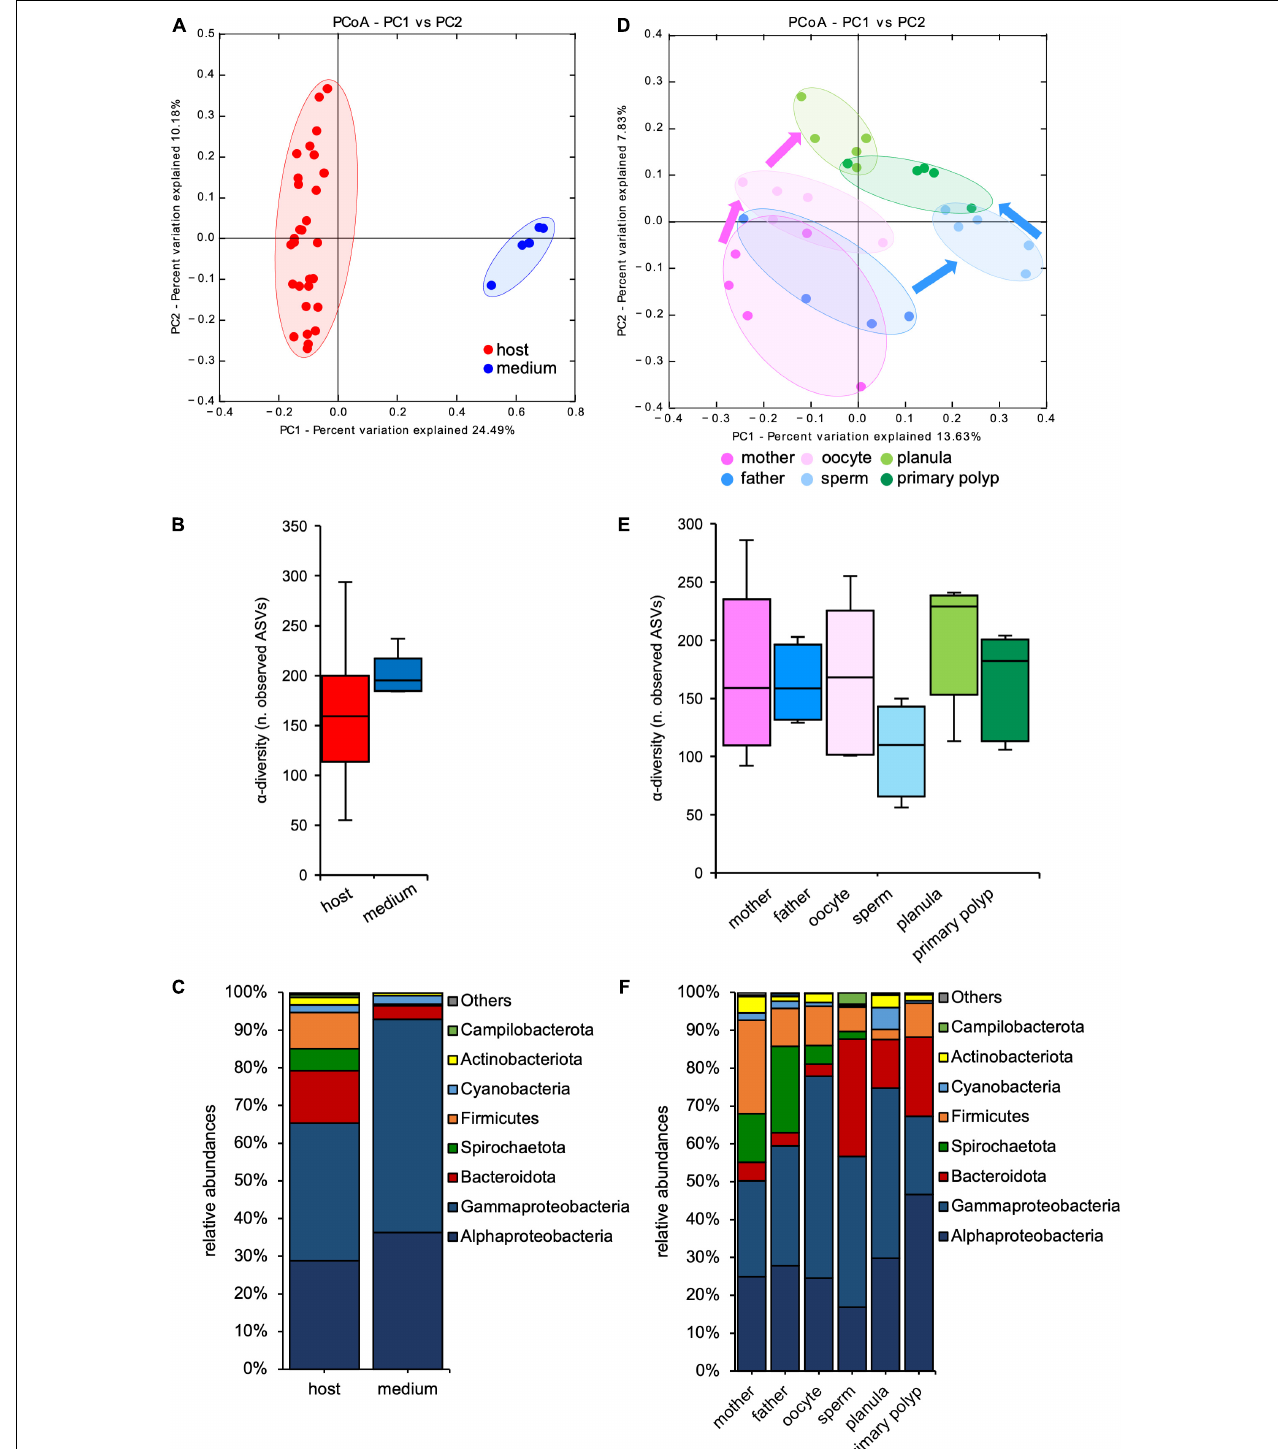
FIGURE 2 | Microbiota diversity analyses among sample source and life stage. (A) PCoA (based on Binary-Pearson metric, sampling depth = 7000) illustrating similarity of bacterial communities based on sample source; (B) α -diversity (observed ASVs) comparison of medium and animal tissue samples (max rarefaction depth = 7000, num. steps = 10); (C) relative abundance of main bacterial groups between host and medium samples; (D) PCoA (based on Binary-Pearson metric, sampling depth = 7000) illustrating similarity of bacterial communities based on developmental stage; (E) α -diversity (observed ASVs) comparison by developmental stage (max rarefaction depth = 7000, num. steps = 10); (F) relative abundance of main bacterial groups among different life stages.